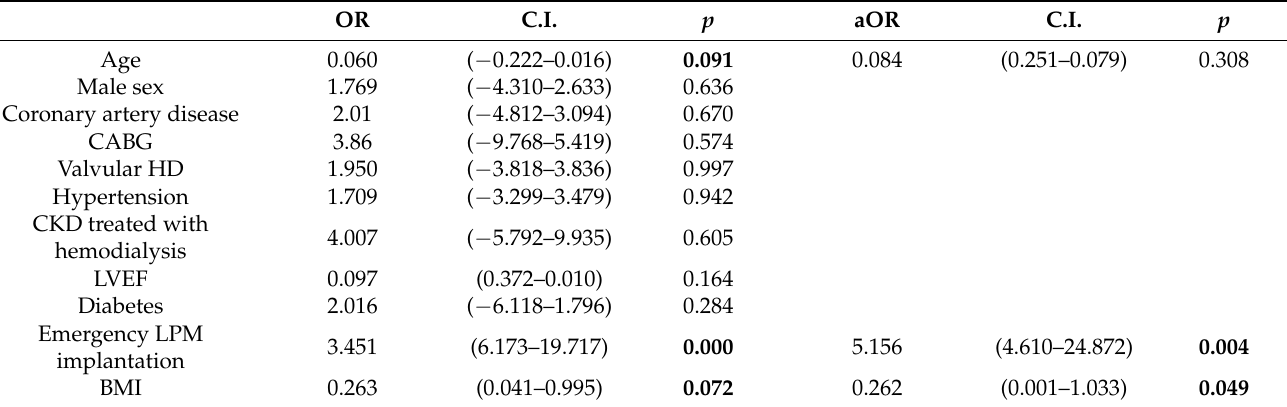
Table 4. Univariate and multivariate analyses for procedural times of LPM